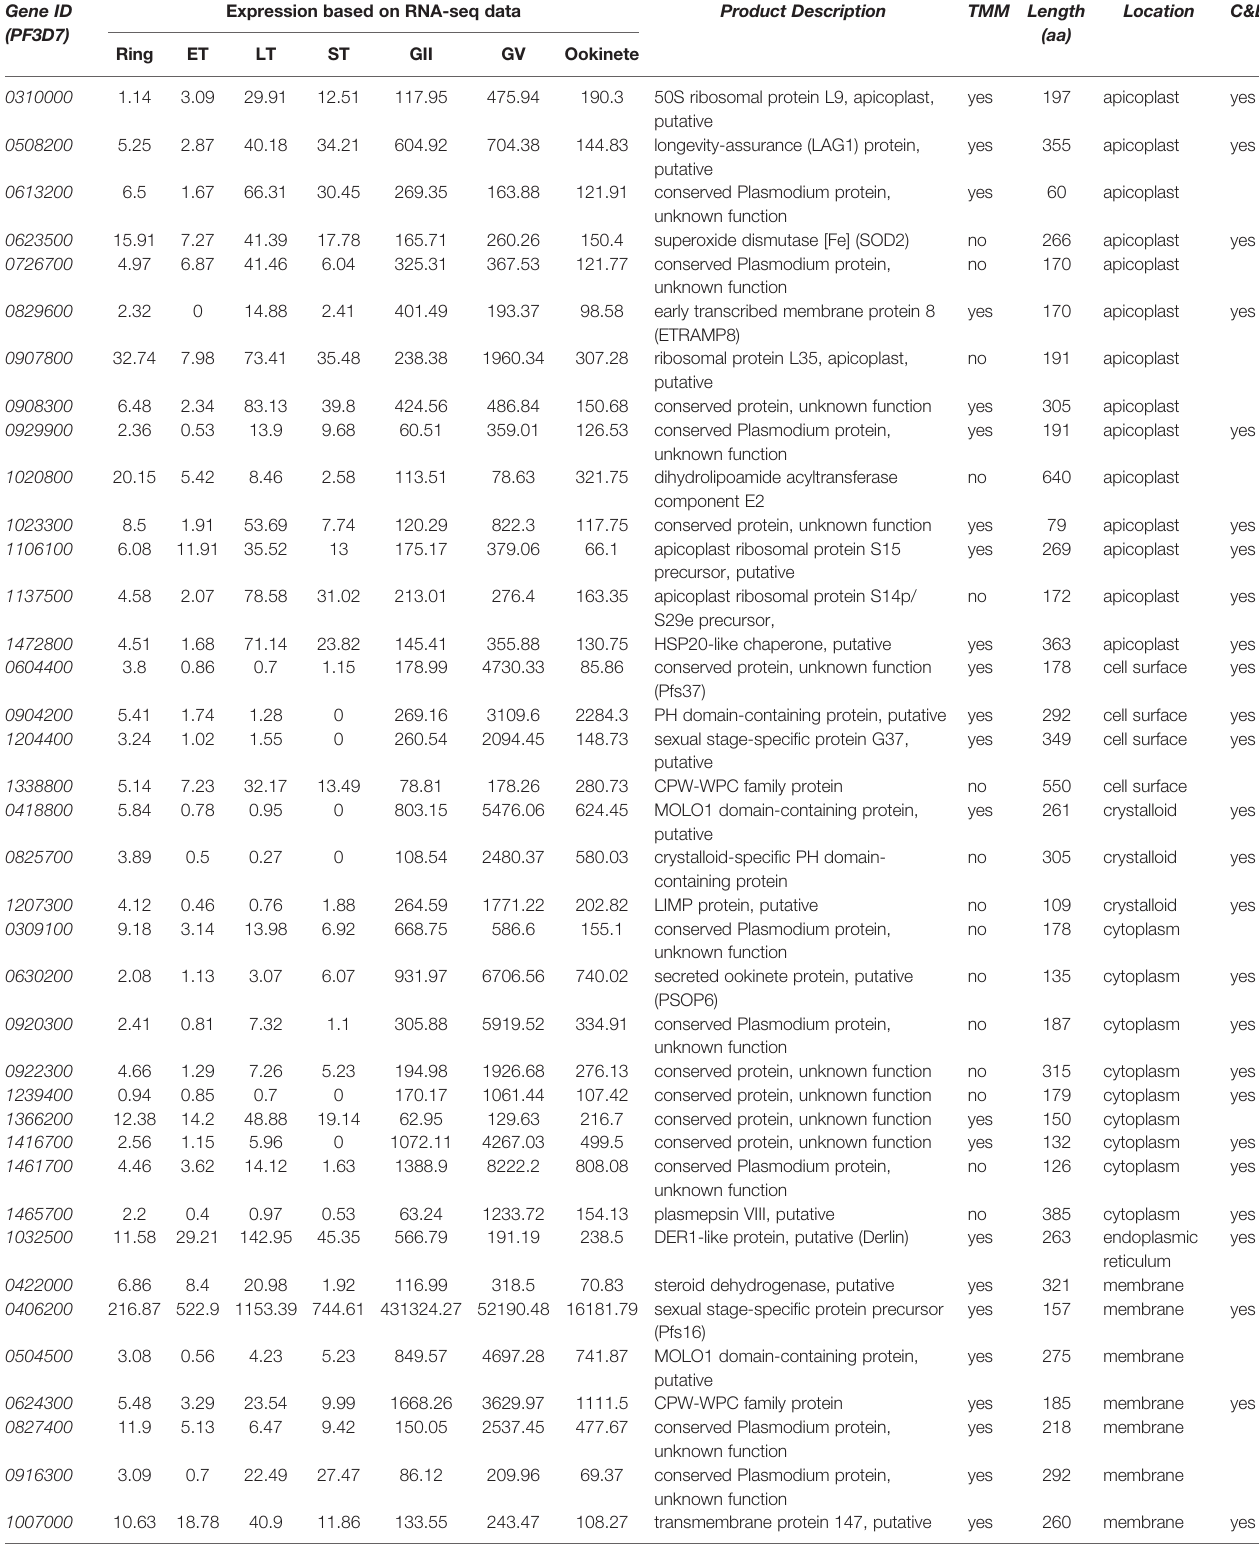
TABLE 1 | The features of selected candidate